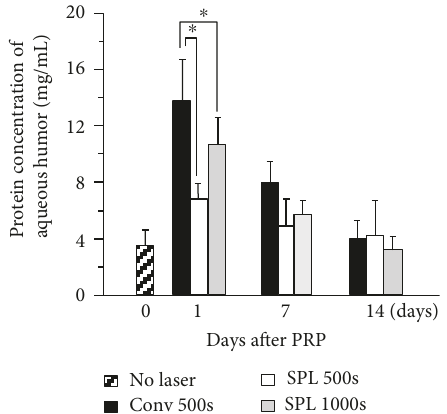
Figure 5: Protein concentration changes in the aqueous humor after panretinal photocoagulation (PRP) using conventional laser with 500 spots (Conv 500), short-pulse laser (SPL) with 500 spots (SPL 500), and SPL with 1000 spots (SPL 1000s). Statistically signi fi cant di ff erence as compared to the Conv group ( ∗ p < 0 05 ). Vertical bars indicate standard deviation ( n = 8